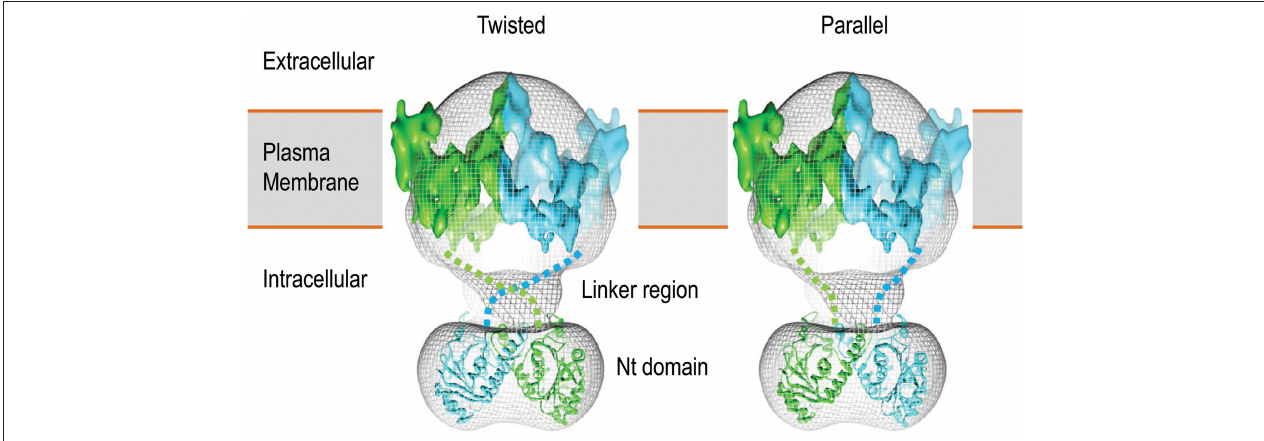
FIGURE 3 | 3D structure model of human AE1 dimers obtained by cryo-EM. Shown here are two potential organizations of the AE1 dimers: twisted (left) and parallel (right). The two molecules of AE1 are shown in different color. The figures are modified from Jiang et al. (2013).